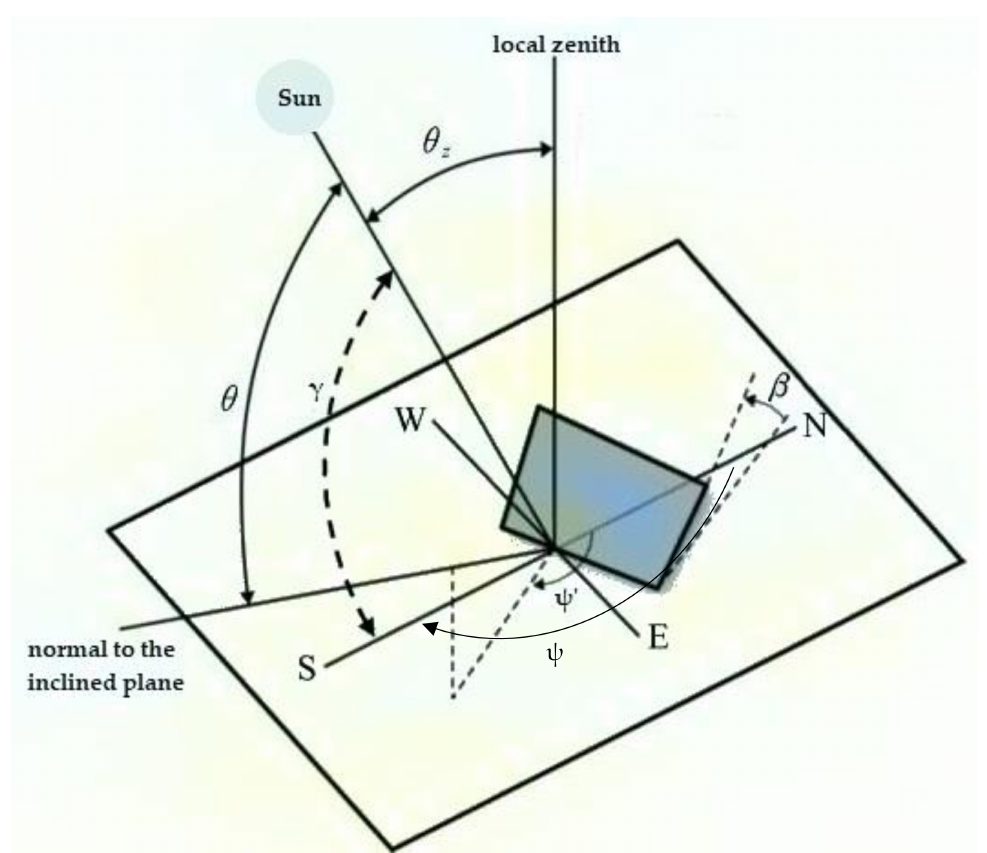
Figure 2. Inclined surface at a tilt angle β with arbitrary orientation. E, W, N, S denote East, West, North, and South, respectively. Moreover, the solar altitude, γ ; the solar azimuth, ψ ; the tilted surface’s azimuth, ψ ’; and the incidence angle, θ , are